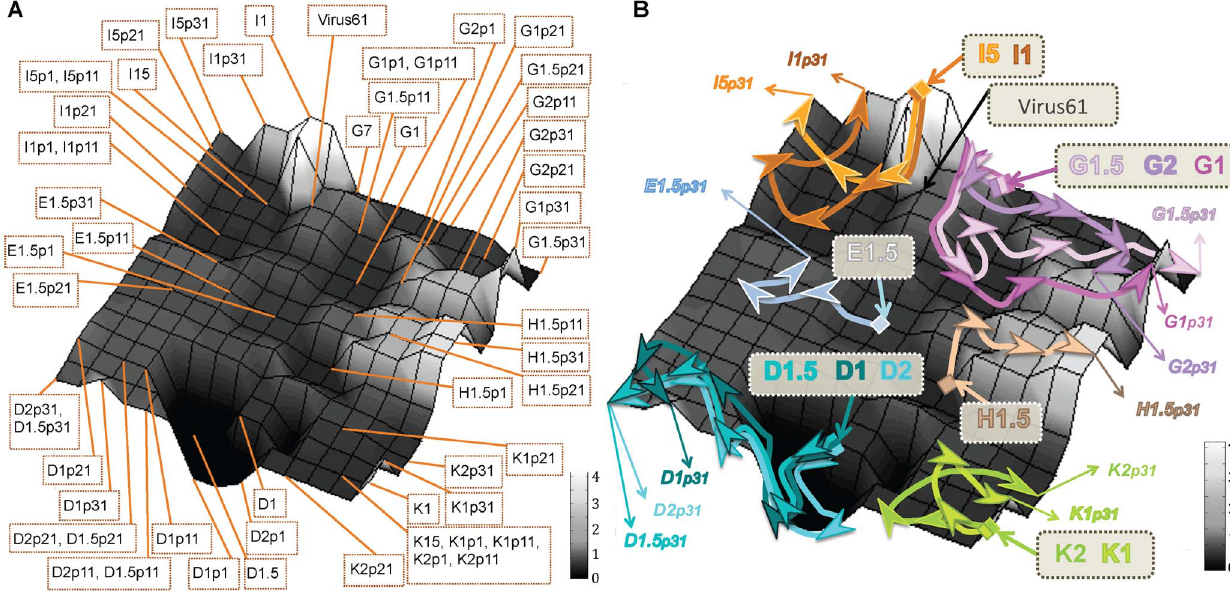
Figure 3. Representation of the fitness landscape of the HIV-1 studied viruses from the complete genome sequences and depiction of the viral recovery pathways. The landscape was constructed by SOM with the complete genomic sequences from the set of 55 viruses (see Figure 1) and labelled with the fitness value of the closest sequence (factor L =1 was used to label the network). The SOM was formed by a grid of 15 6 15 neurons (Fig. S1). Each vertex of the bi-dimensional mesh symbolized a neuron of the SOM network. Grey scale of the landscape represents the fitness values, from the lowest values in black to the highest in white. A) Fitness landscape showing the neuron that maps each viral sequence. B) Fitness landscape map displaying the pathways followed by the different viruses during the recovery passages, where the viruses from the same lineage are linked with the same colour arrow.